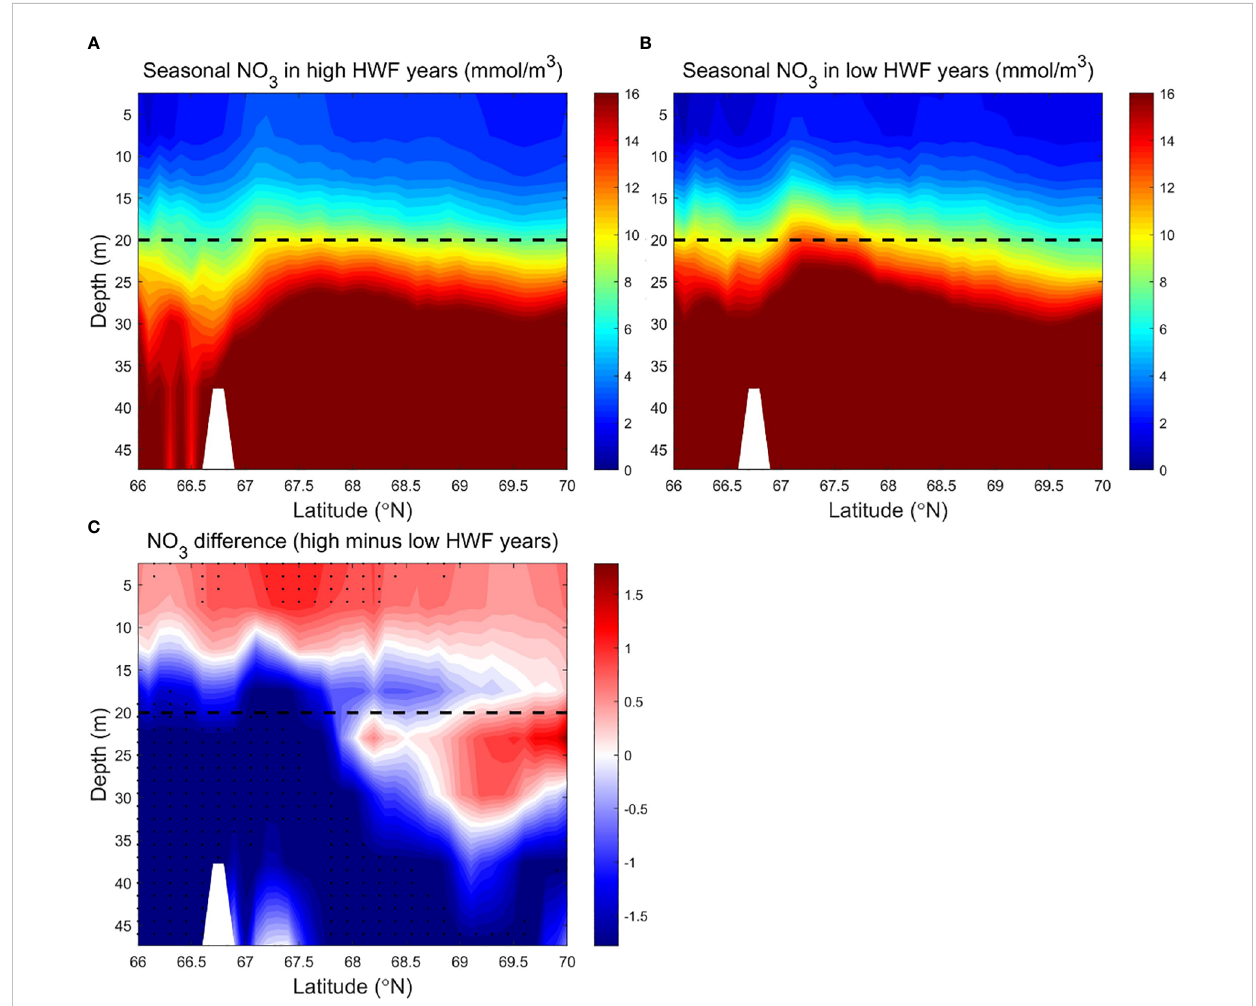
FIGURE 6 Modeled seasonally (June to September) averaged NO 3 (mmol/m 3 ) in the SC in the (A) high (1990, 1996, 2001, 2011, 2012) and (B) low (1992, 1995, 2002, 2004, 2007) HWF yeas, and (C) their differences (high minus low). The dashed lines denote 20 m depth. In Figure 6C, black dots denote where p <0.19, because there is no area where p